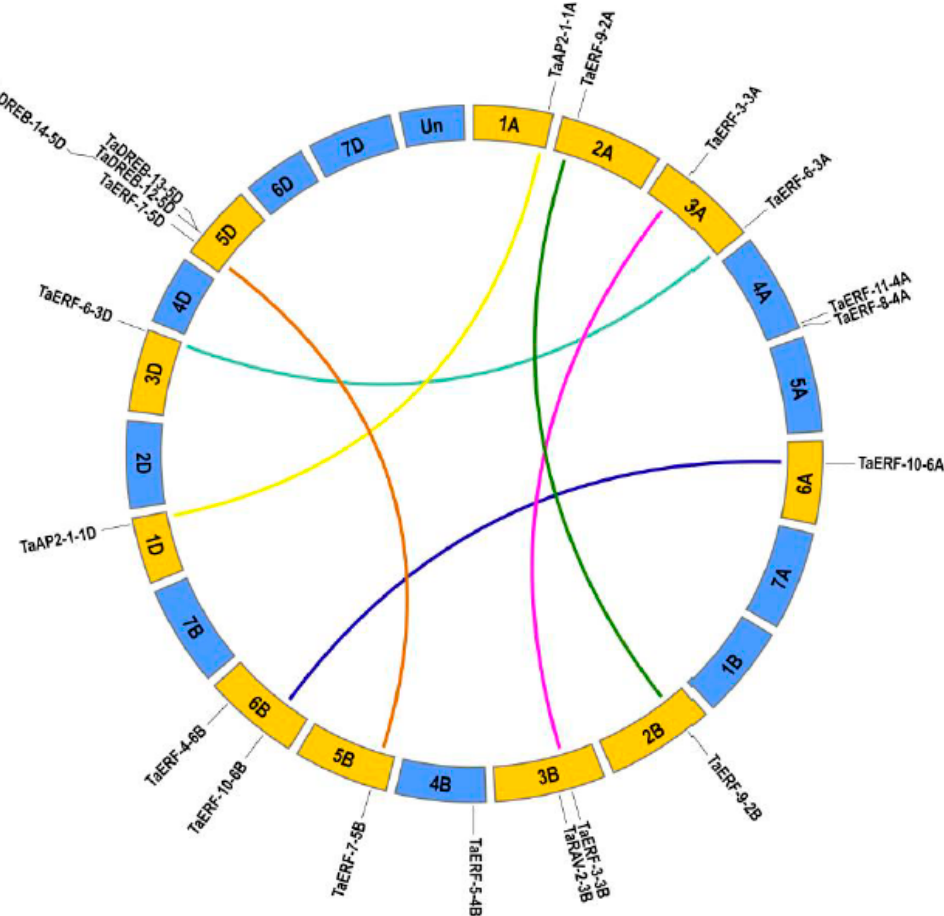
Figure 1. Chromosome distribution of TaAP2/ERF genes. Colorful lines indicate homologous copies (distributed among A, B, or D sub-genomes).